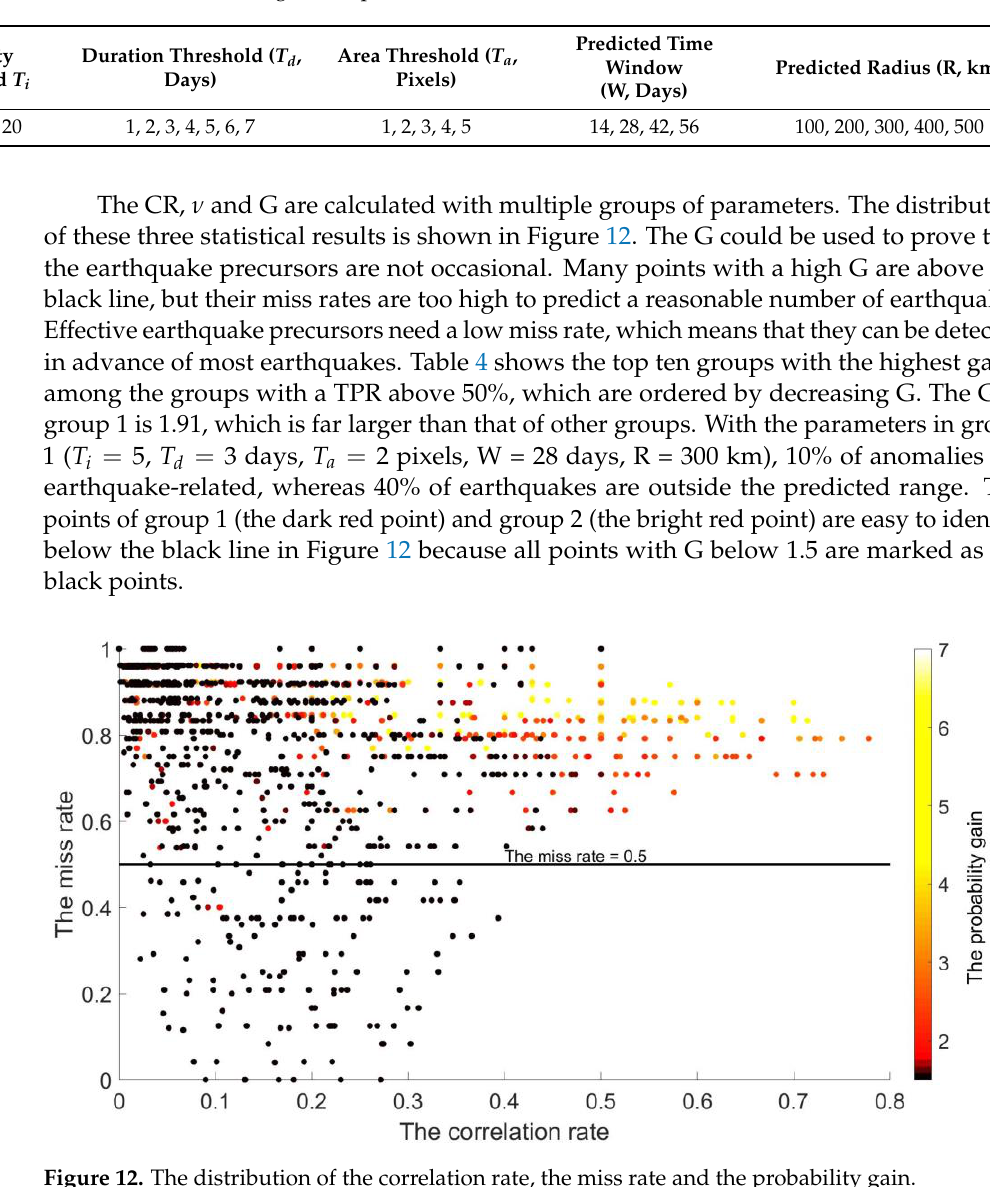
Table 3. The value of algorithm parameters.